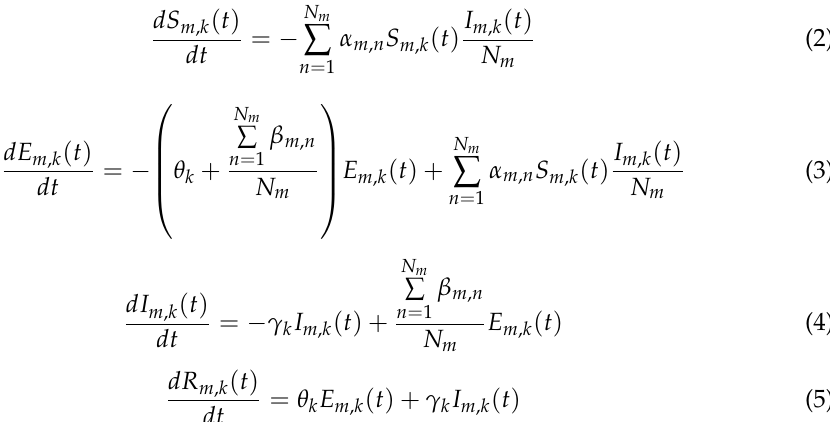
Figure 3. Information dissemination dynamics model of UEN.